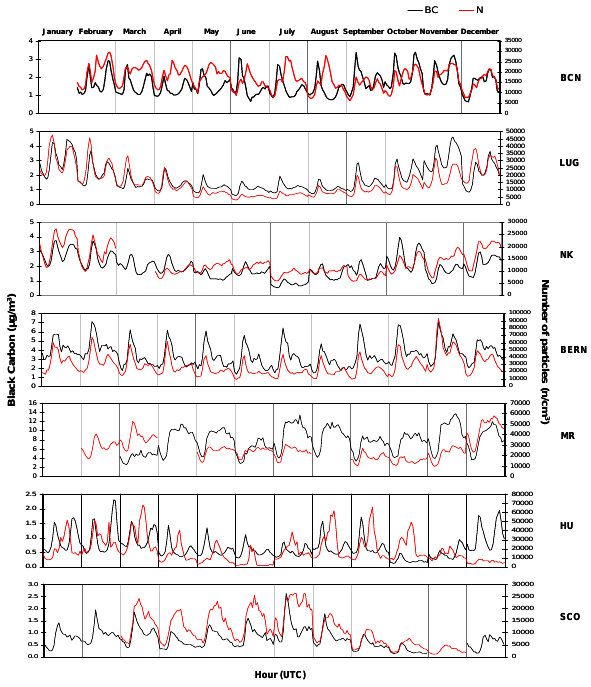
4 5 Figure 4. Daily cycle of BC and N for each month. 6 Fig. 4. Daily cycle of: BC and N for each